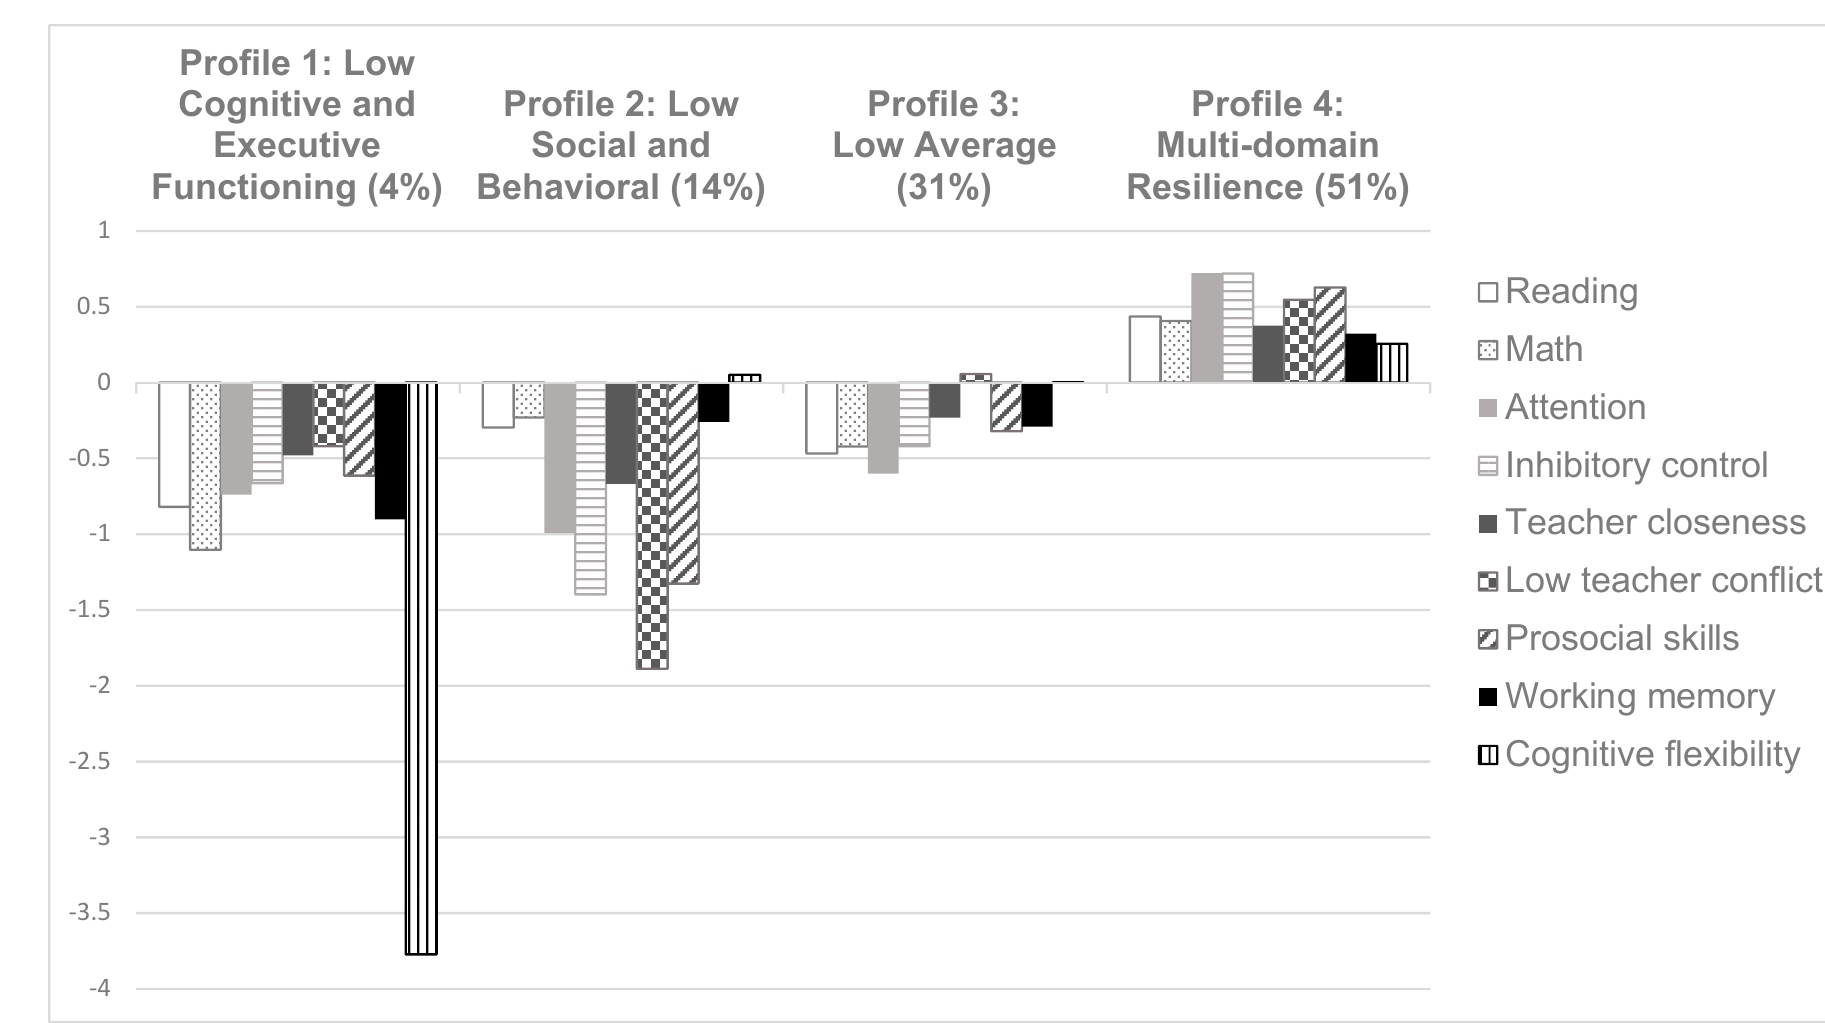
Figure 1. Latent Profiles of Resilience.